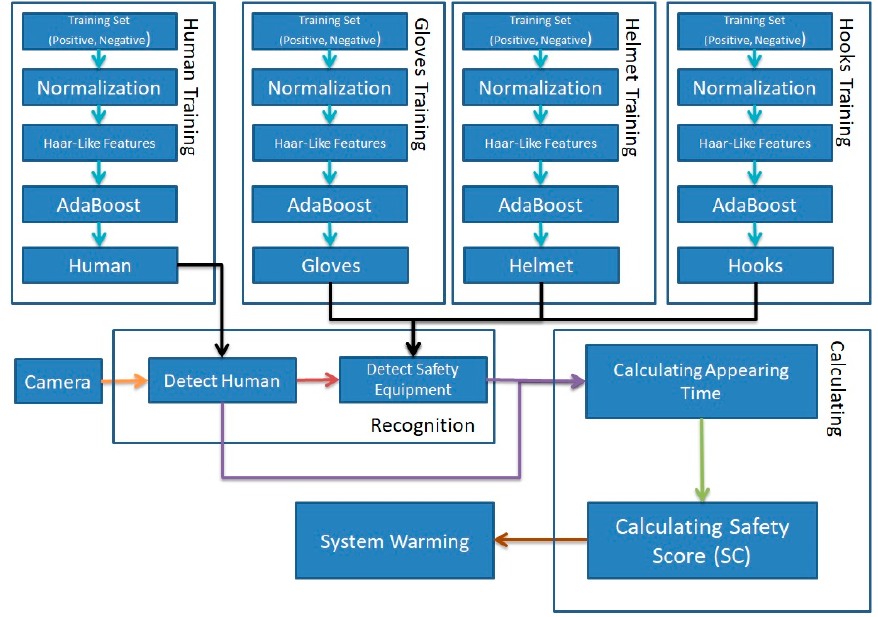
Figure 5. Safety system process diagram.